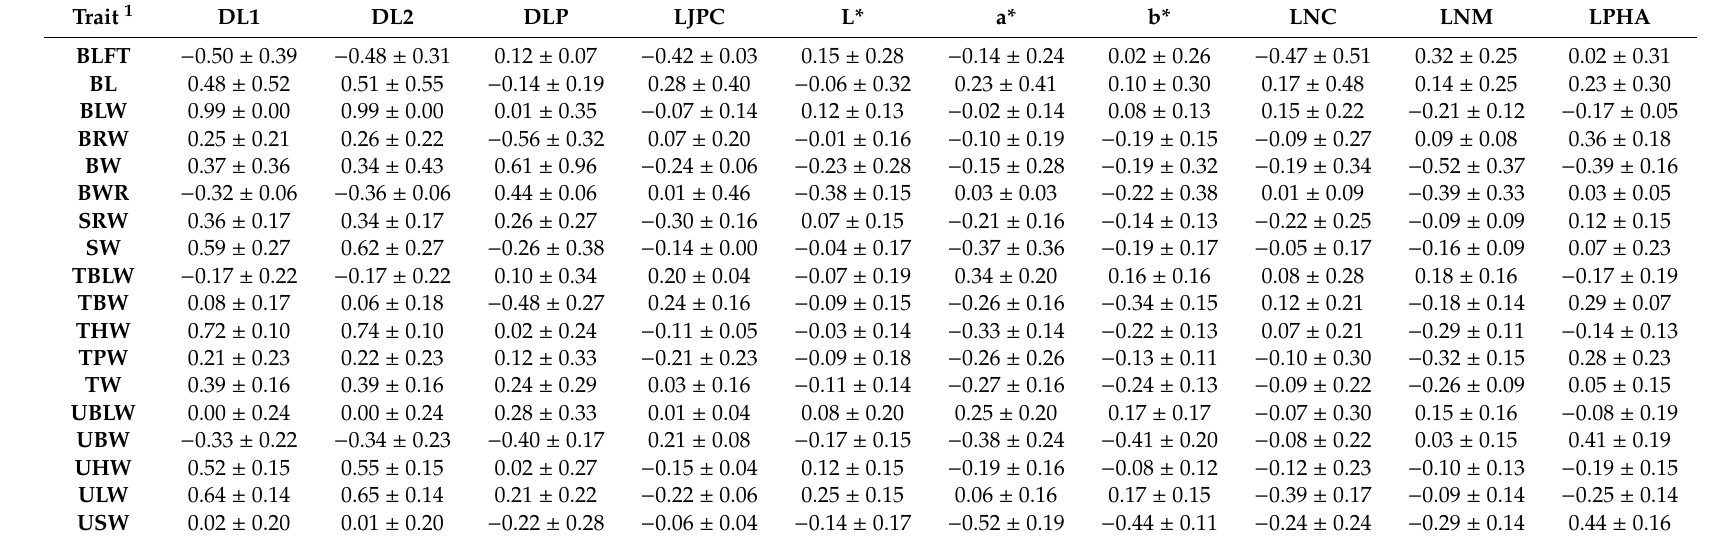
Table 9. Genetic correlations between pork quality and novel carcass